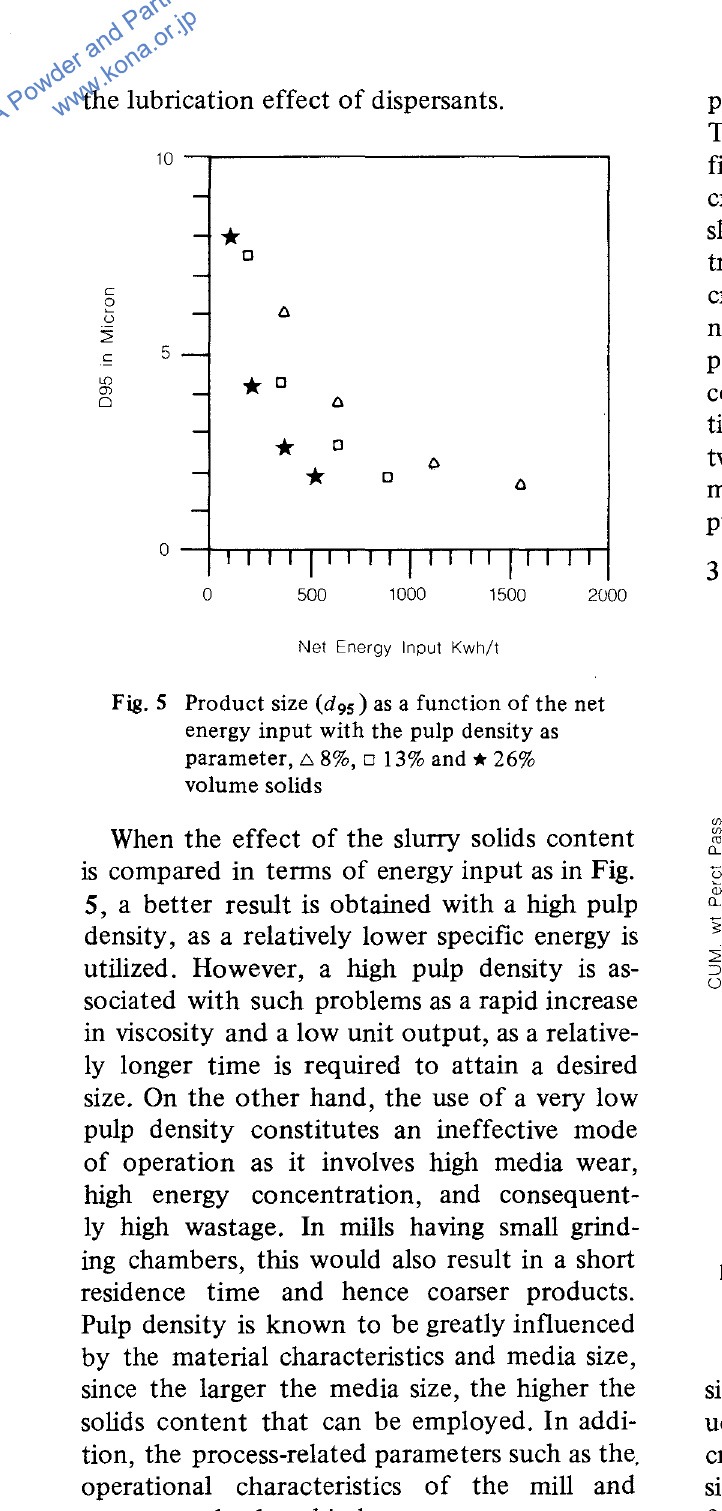
Fig. 6 Product size distribution with grinding media size as paramter, 6 0.59 mm, o 0.83 mm and it 1.42 mm media